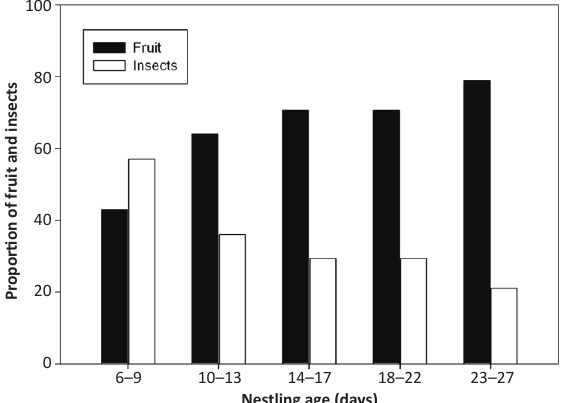
Figure 1. Percentage of fruit and insects in nestling diet of Bolivian Swallow-tailed Cotingas according to age